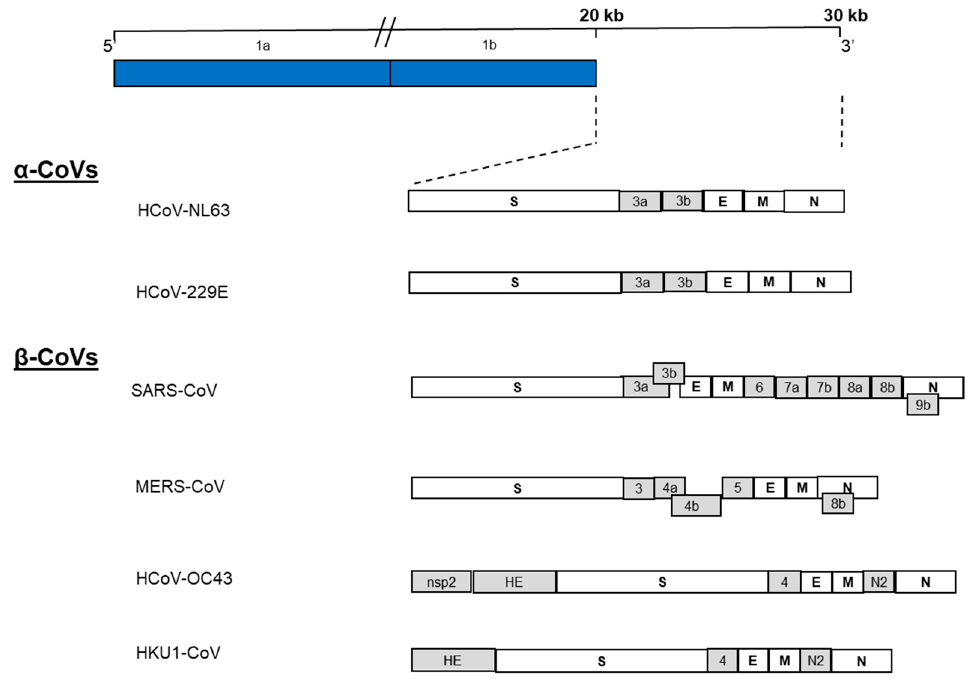
Figure 1. Schematic organization of human coronavirus ( α and β CoVs) genomes. HCoVs genomes are 26 kb to 32 kb in size. At the 5 ′ -end, overlapping reading frames 1a and 1b (blue) make up two-thirds of the genome. The remaining one third of the genome (expanded region) encodes for the structural (white) and accessory proteins (grey).